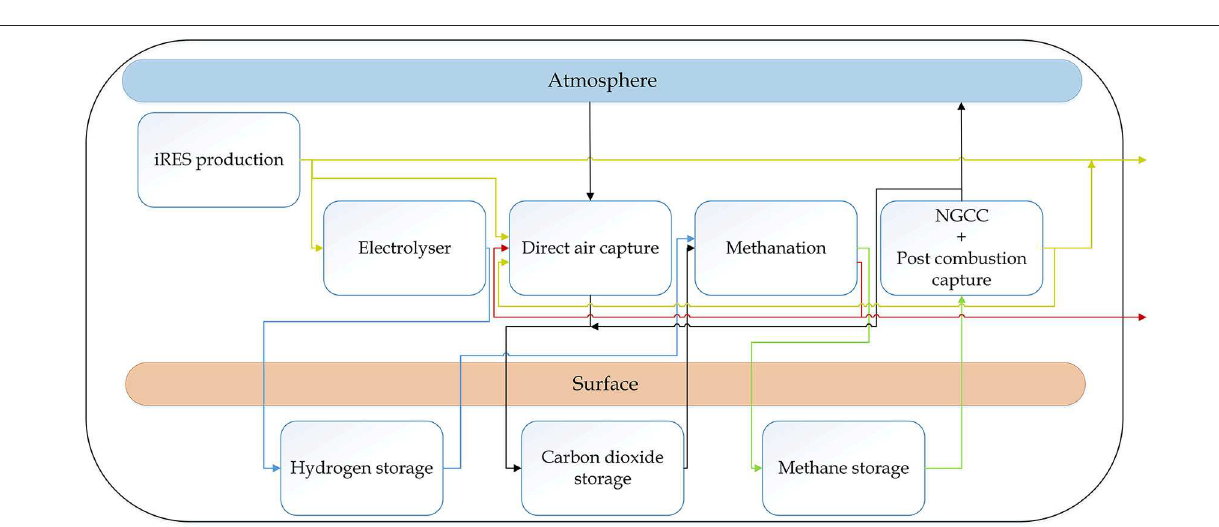
Frontiers in Energy Research |